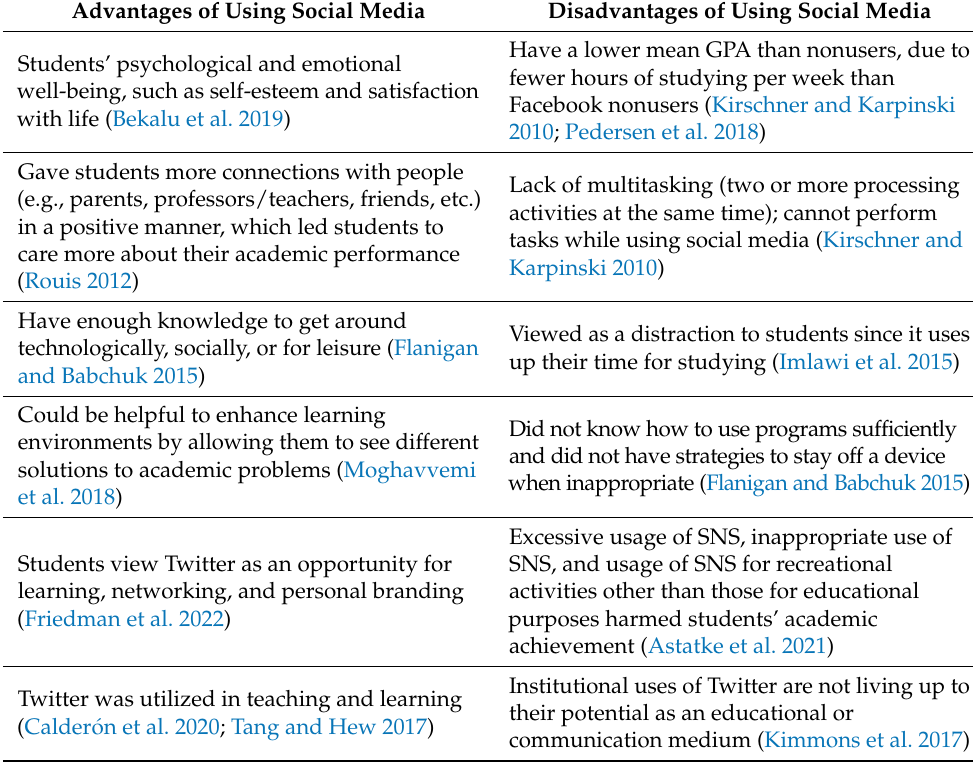
Table 1. Summary of the literature in favor and against the use of Twitter for students. Advantages of Using Social